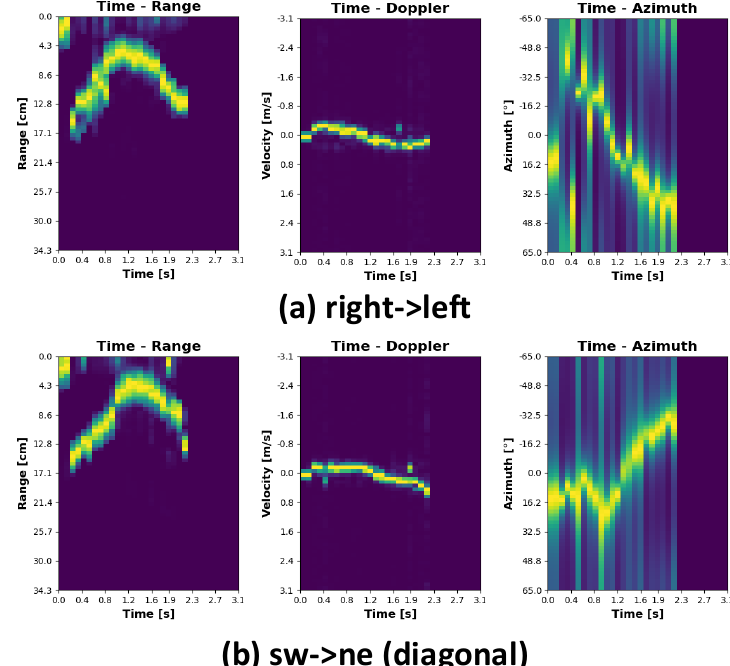
Figure 10. Gesture signatures